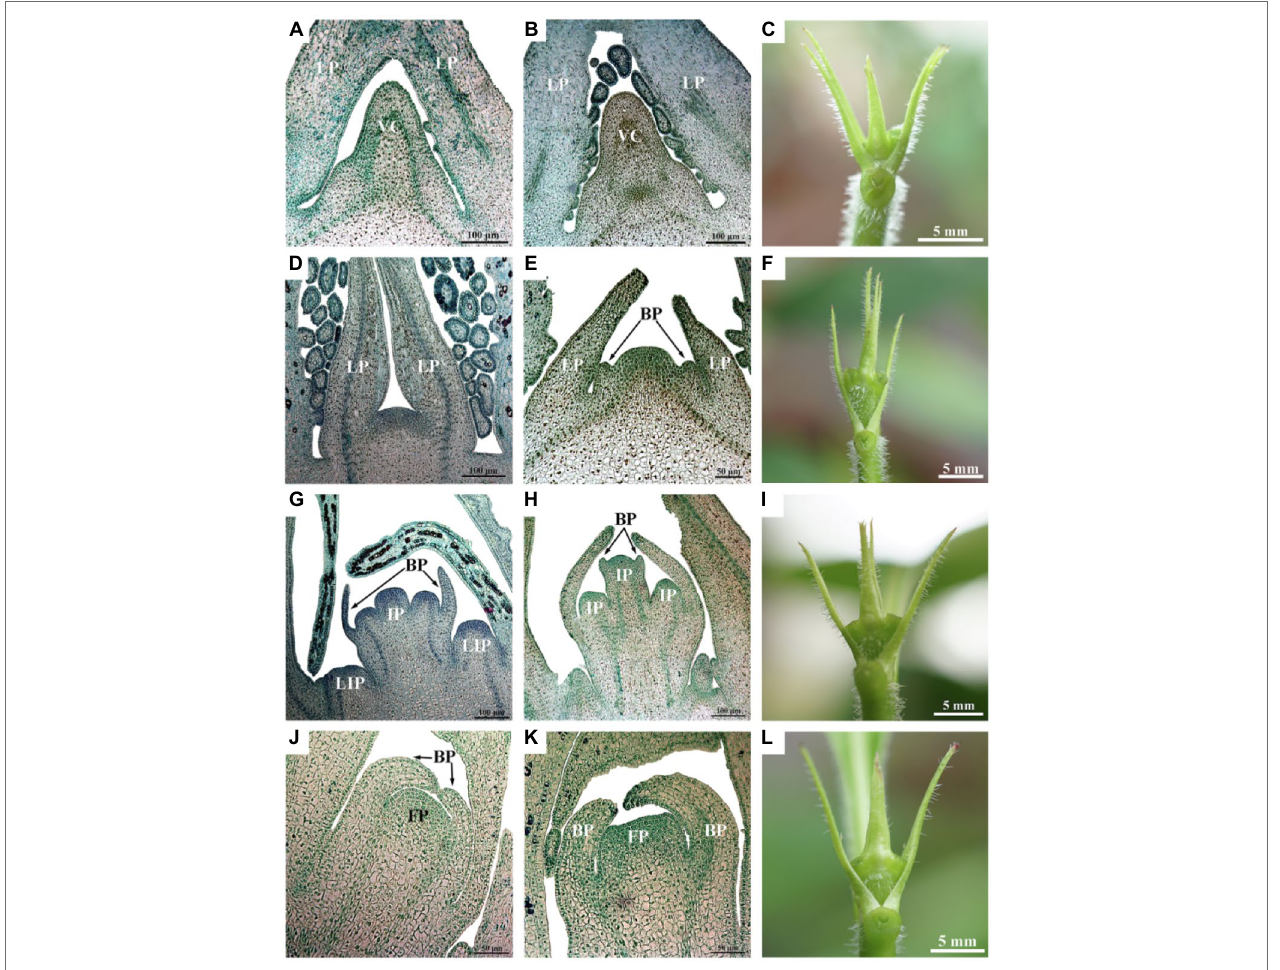
FIGURE 2 | Luculia gratissima morphological and histological characteristics, shoot apexes at five time points upon short-day treatment. (A–C) Vegetative buds in the undifferentiated stage (SD0 to SD7). (D–F) Bract primordial differentiation stage (SD10). (G–I) Inflorescence primordial differentiation stage (SD13). (J–L) Floret primordial differentiation stage (SD19). (A,B,D,G,H) Histological images obtained from paraffin-embedded sectioned samples (scale bar: 100 μ m). (E,J,K) Histological images obtained from paraffin-embedded sectioned samples (scale bar: 50 μ m). (C,F,I,L) The external morphology of shoot apexes at different developmental stages (scale bar: 5 mm). BP, bract primordia; FP, floret primordia; IP, inflorescence primordia; LIP, lateral inflorescence primordium; LP, leaf primordia; and VC, vegetative